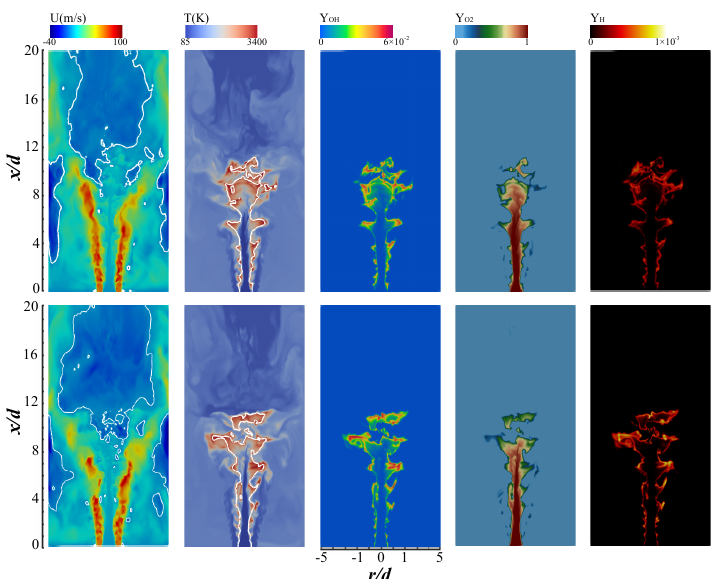
Figure 7. Representative snapshots in a slice of the calculation domain of the axial velocity, tempera- ture, and mass fractions of OH, O 2 , and H in the 3D LES. Case 1 is listed in the first line, while Case 2 is in the second. The solid white lines in the first column indicate the isolines that the axial velocity is equal to 0, and the solid white lines in the second column indicate the isolines of the stoichiometric ratio mixture